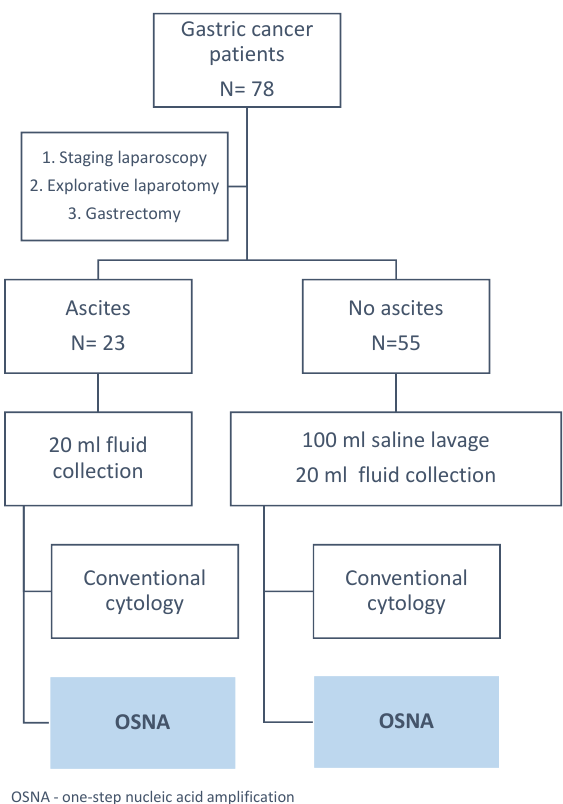
Figure 1. Study design. OSNA: One-Step Nucleic Acid